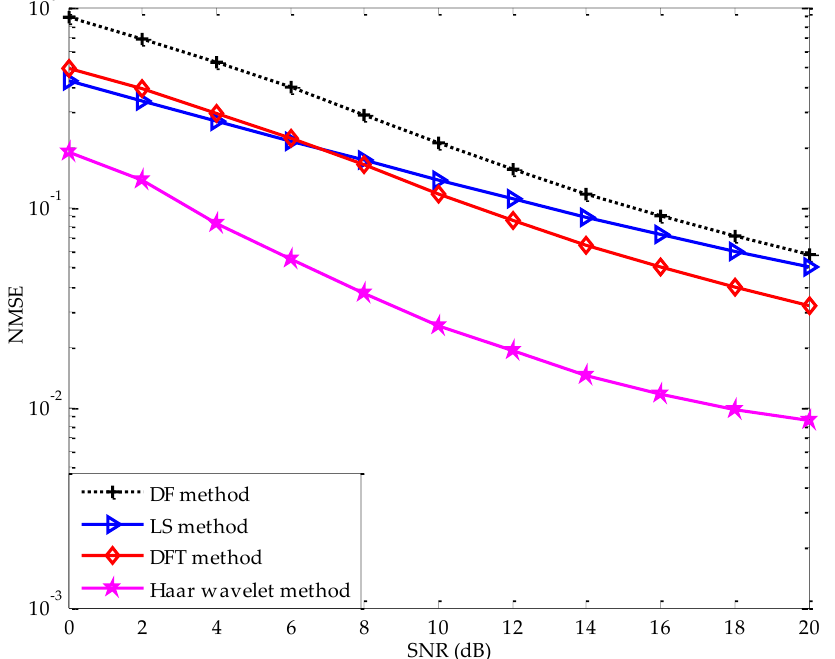
Figure 7. Normalized mean square error (NMSE) performance of QPSK modulated CP-OFDM and wavelet-OFDM systems under CDT1 channel.